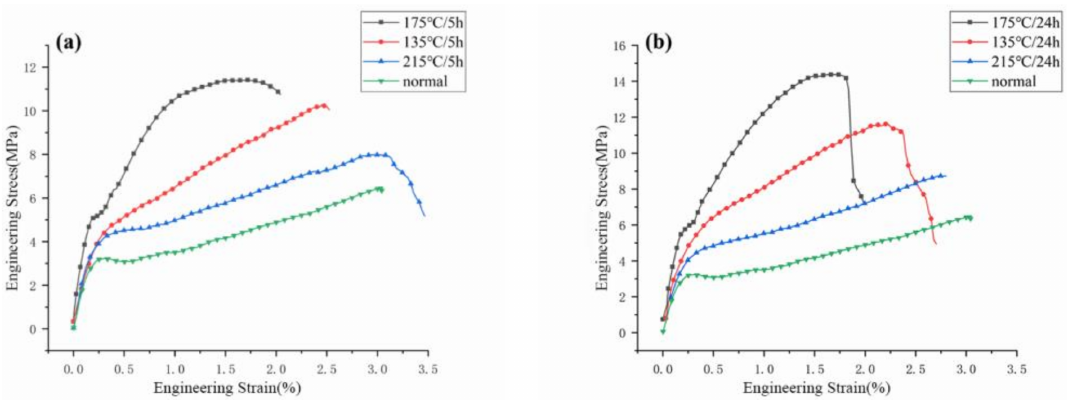
Figure 10. Average flexural stress vs. deformation of specimens after baking for ( a ) 5 h and ( b ) 24